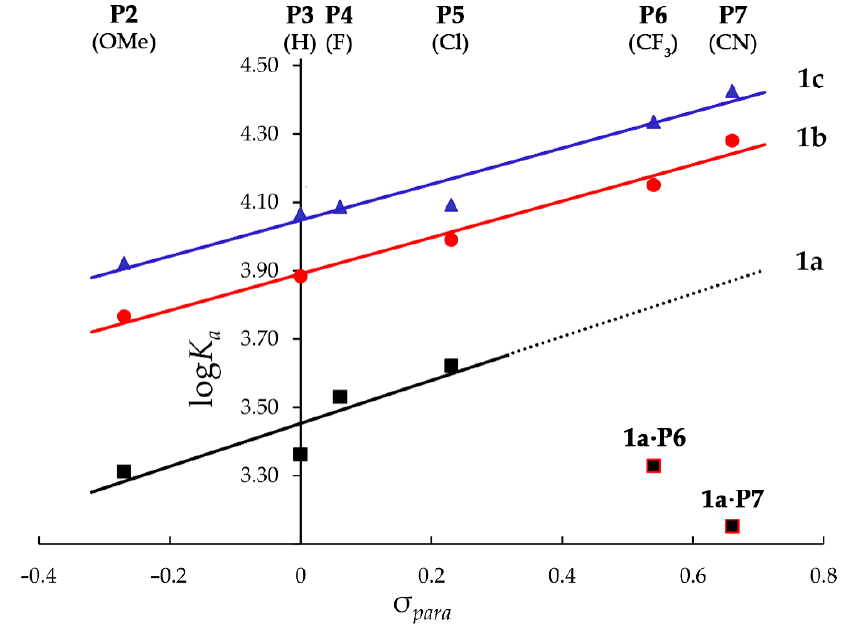
Figure 5. Hammett plots of log K a vs. σ para constants for coordination of 1a (black points, outliers are marked with red rim), 1b (red points), and 1c (blue points) to zinc tetraphenylporphyrins P2 – P7 with para substituents in the benzene rings.